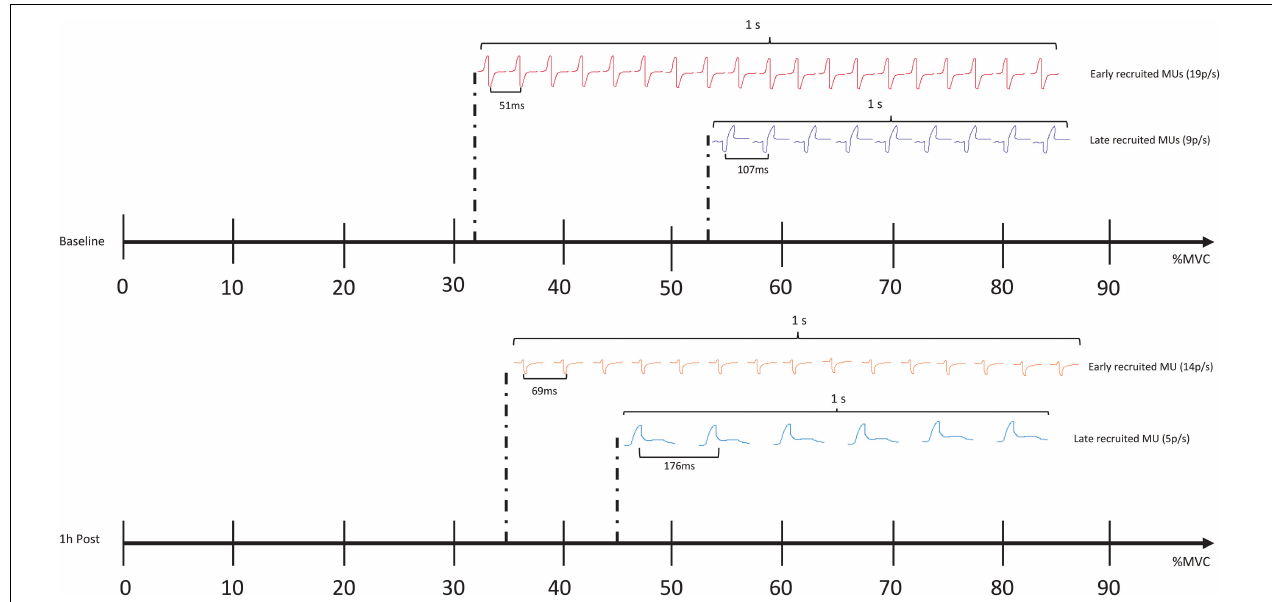
FIGURE 5 | Comparing the recruitment threshold (%MVC) of the individual motor units (MUs) against their average firing rate (pulses per second – p/s) using a linear regression shows a negative shift in the regression line 1 h following sparring. The finding suggests that the recruitment patterns and the firing rates of the MUs as a whole are altered; the early recruited, small motor units are activated later compared to baseline, and the frequency with which they propagate on the sarcolemma of the muscle is slowed down (showed by an increase in the average inter-pulse interval – IPI, and a decrease in how many pulses are discharged per second). The later recruited, big motor units are activated earlier compared to baseline, yet also show an increase in IPI and a decrease in the pulses discharged per